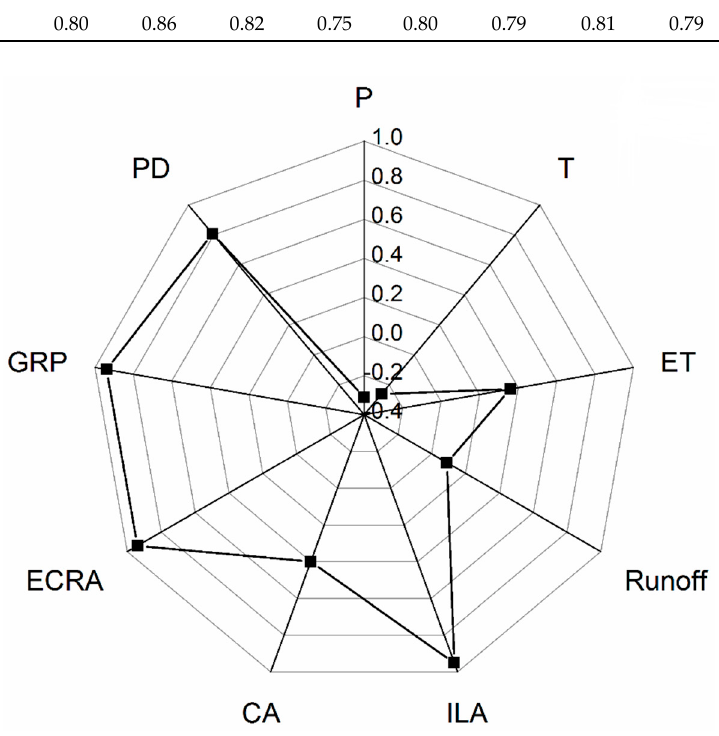
Figure 7. Radar plot about the correlation coefficient of the nine factors.